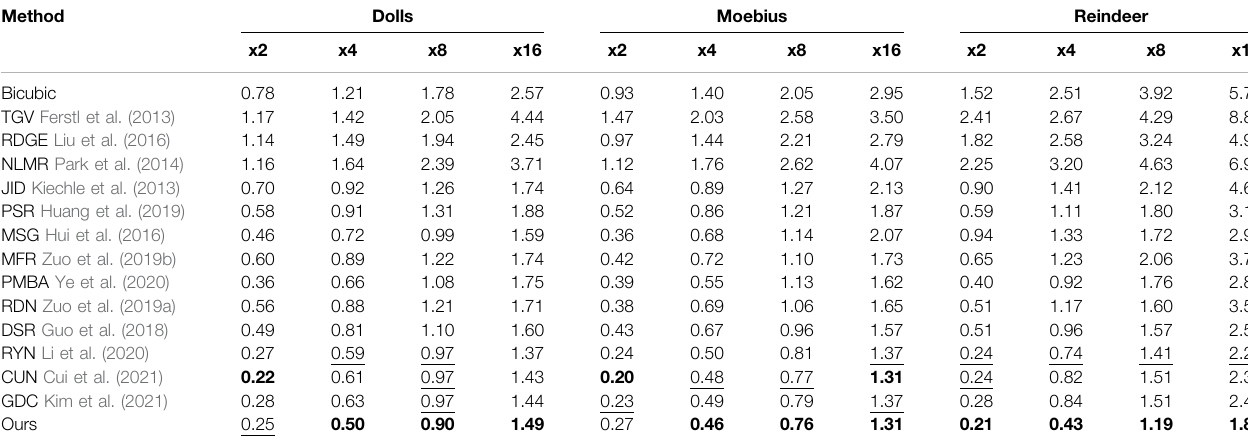
TABLE 2 | Quantitative comparisons on “ dolls, ” “ moebius ” and “ reindeer ” from the noise-free middlebury dataset in terms of RMSE values for different scaling factors. Method Dolls Moebius